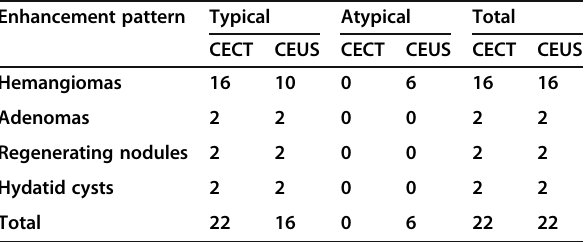
Table 3 CECT and CEUS enhancement patterns showed in patients with benign